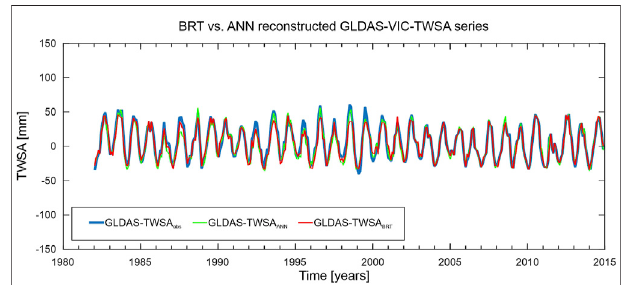
FIGURE7 | Reconstructed time seriesofGLDAS – TWSA; the blue lineis the original GLDAS – TWSA time series (observation), the red line is the GLDAS – TWSA time series as estimated by BRT, and the green line is the GLDAS – TWSA time series as estimated by